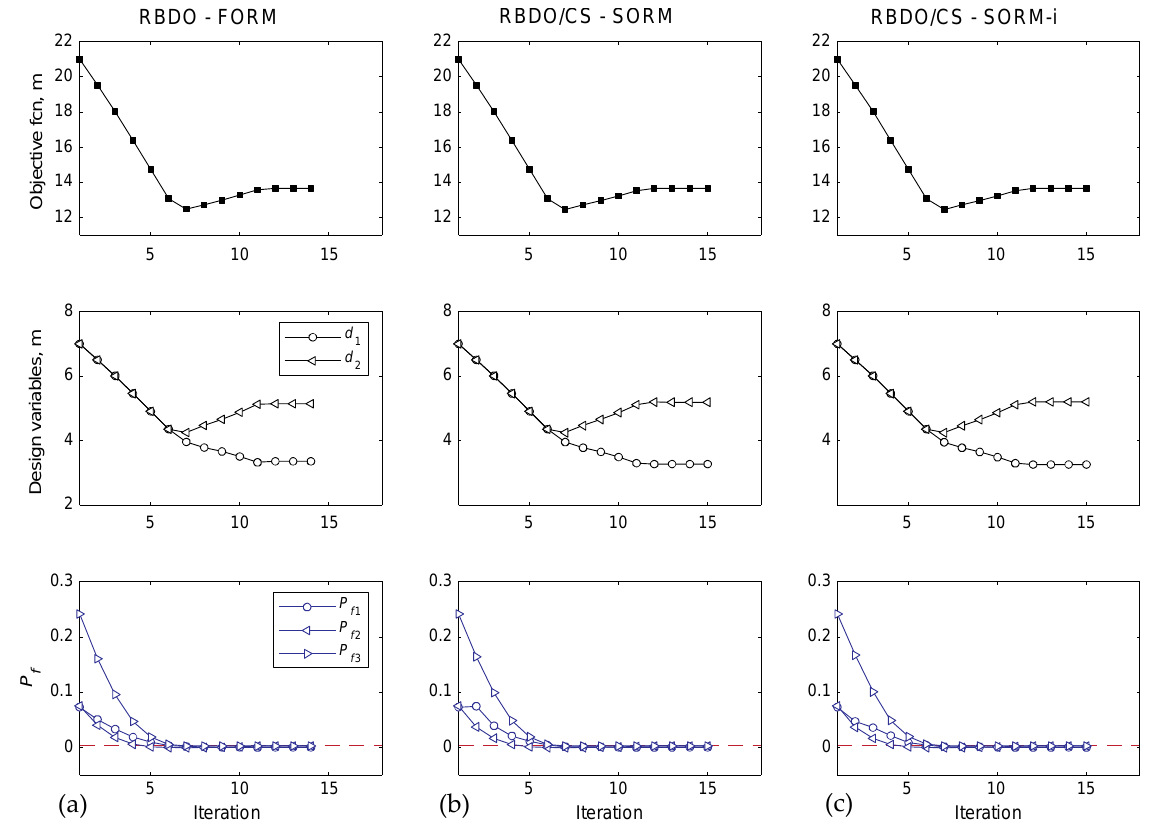
Figure 10. Convergence history of the objective function, design variables, and failure probability pertaining to the ( a ) RBDO – FORM, ( b ) RBDO/CS – SORM, and ( c ) RBDO/CS – SORM-i. Table 12. Results of the RBDO/CS – SORM/SORM-i and RBDO – FORM for the ductile frame structure.